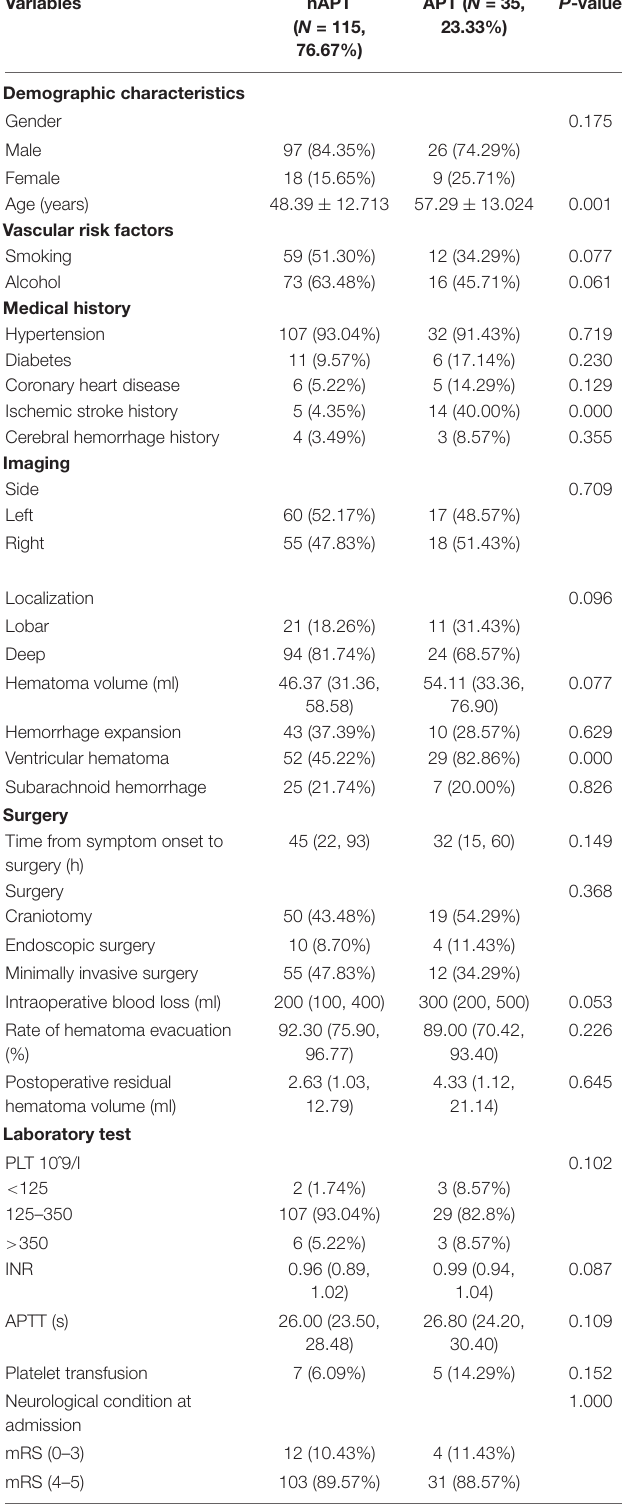
TABLE 1 | Patient’s baseline characteristics according to preoperative APT.